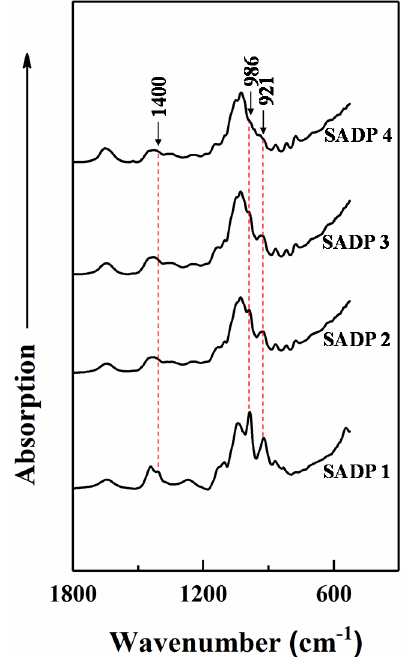
Figure 7. ATR FT-IR spectra of synthesized SADP adhesives after freezing Figure 7. ATR FT ‐ IR spectra of synthesized SADP adhesives after freezing dry.